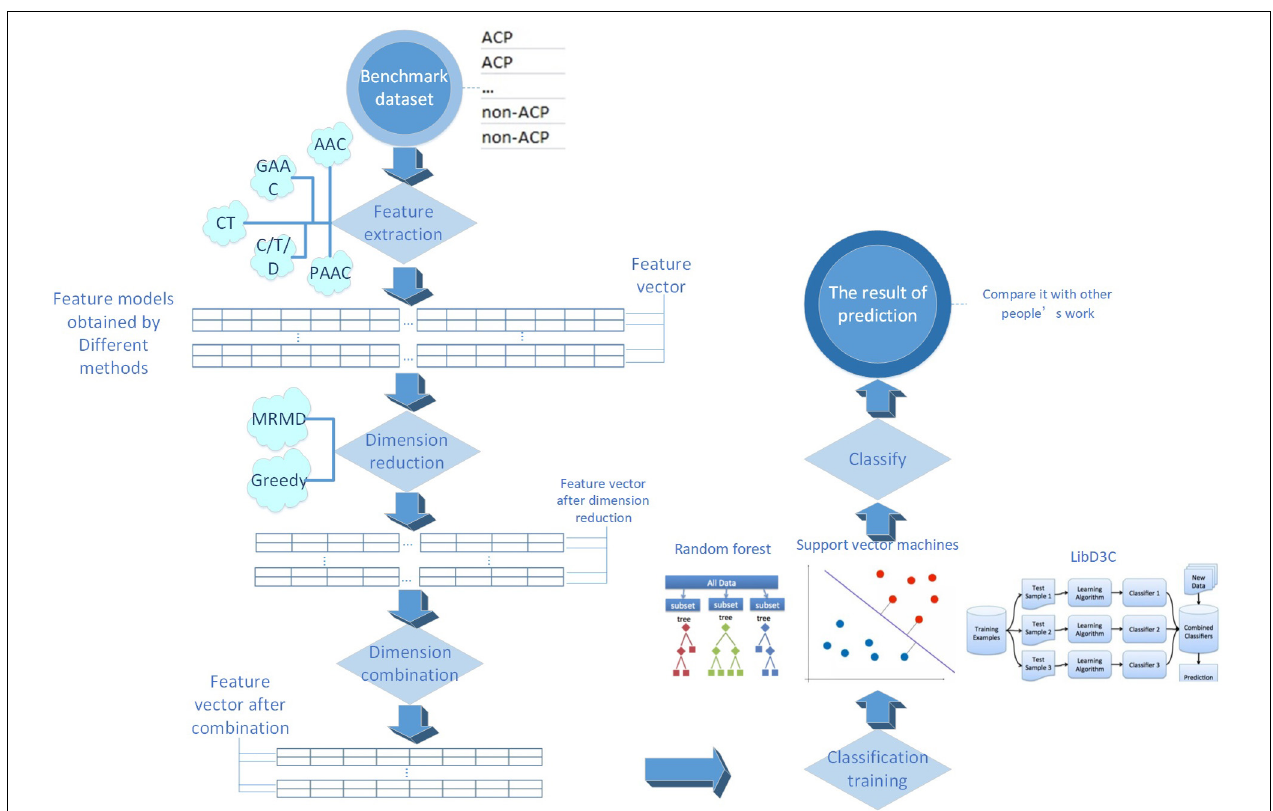
FIGURE 1 | The main flow chart of the research process in this